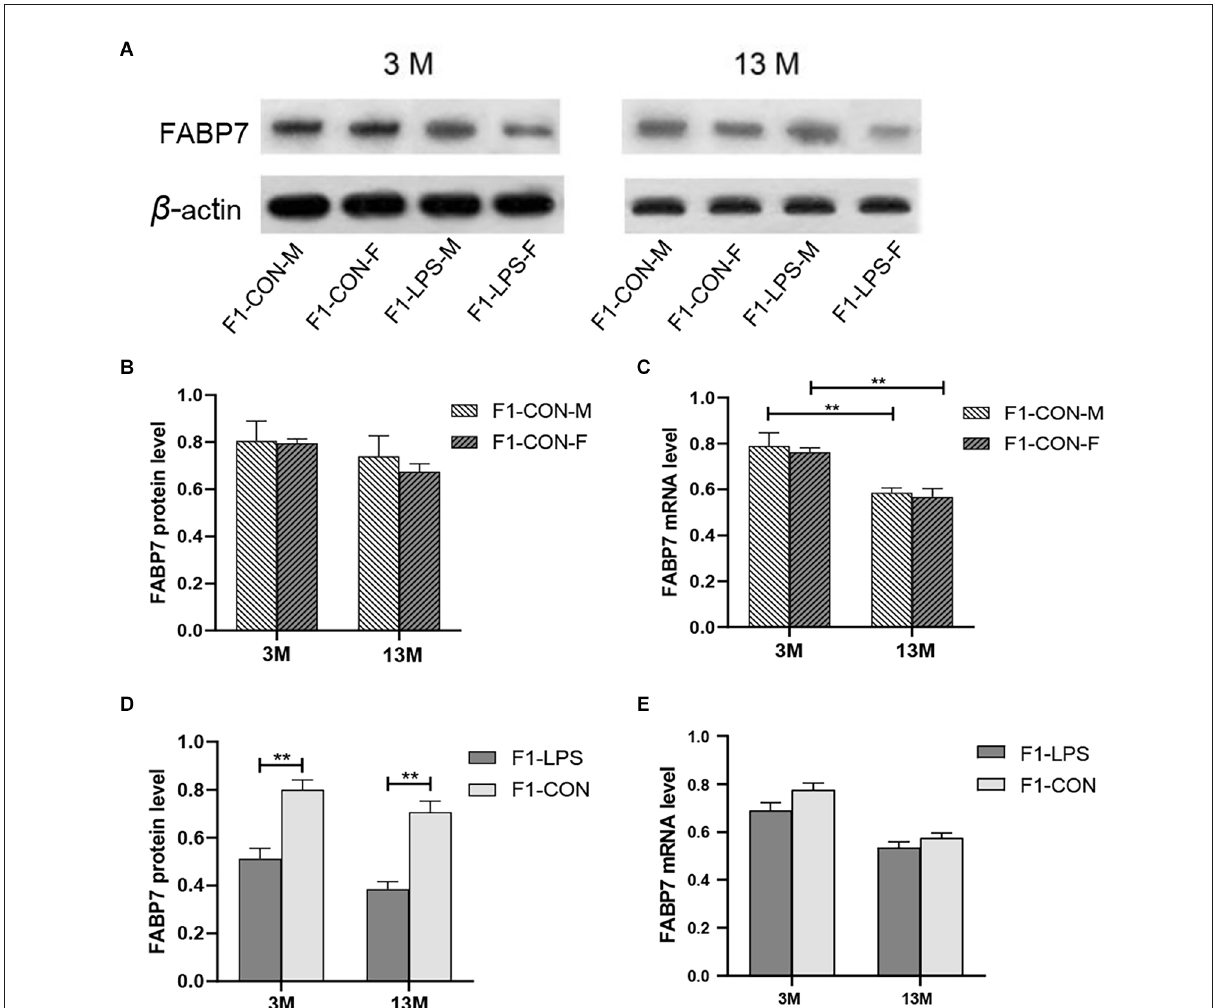
FIGURE6 FABP7 protein and mRNA expression levels in F1 generation mice. (A) Representative FABP7 immunoreactive bands in the hippocampi of F1 mice in the different groups at different ages. (B,C) FABP7 protein and mRNA levels in the hippocampi of mice at different ages in the control groups; n = 6 male or female mice/group. Error bars = standard error of the mean (SEM). ** P < 0.01 compared with the 3 M group. (D) FABP7 protein and (E) FABP7 mRNA levels in the hippocampi for 3- (3 M) and 13-month-old (13 M) CD-1 mice in different groups; n = 12 per group. Error bars =